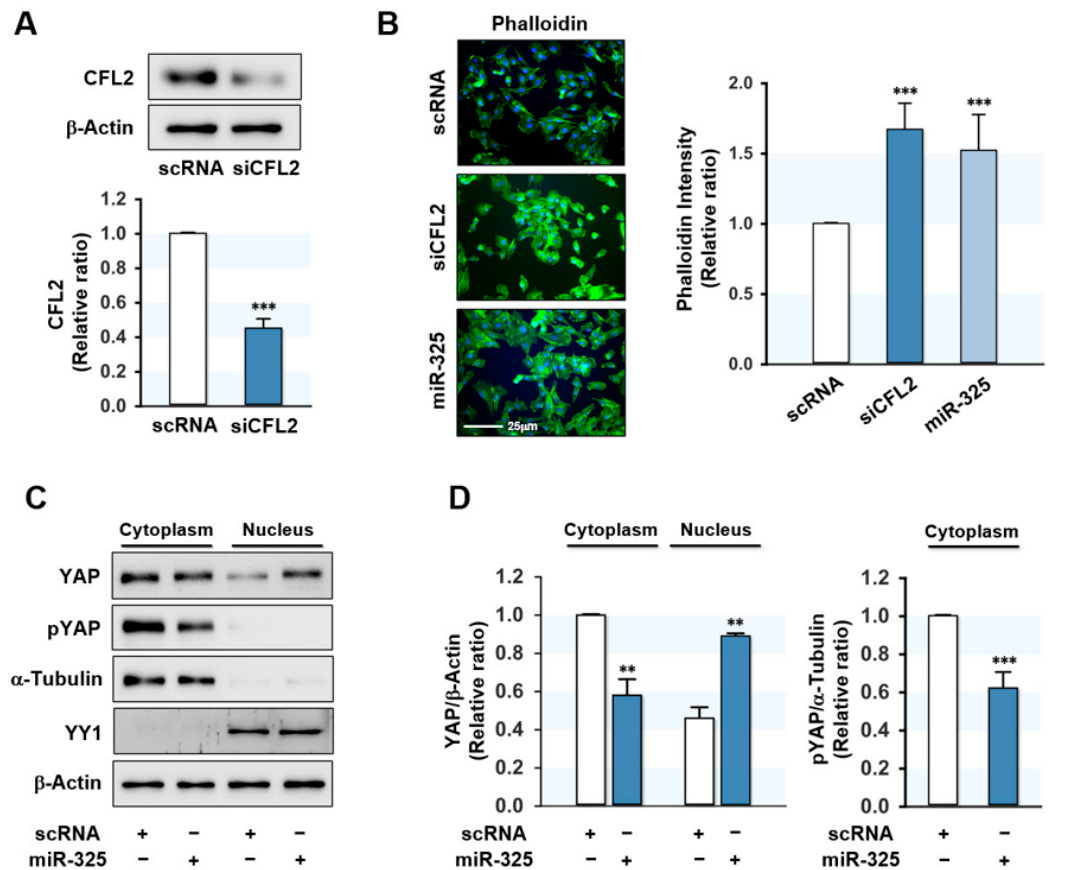
Figure 3. MiR-325-3p increased F-actin and nuclear YAP levels. ( A ) C2C12 myoblasts were transfected with 200 nM of scRNA or CFL2 siRNA (siCFL2), and CFL2 protein expression was determined 24 h after transfection by immunoblotting. Intensities were normalized versus β -actin. ( B ) Representative images of FITC-phalloidin (green) and Hoechst 33342 (blue) staining after 24 h of transfection. Scale bar: 25 μ m. Phalloidin intensities were analyzed by ImageJ software. ( C , D ) YAP and phosphorylated YAP (pYAP) protein expressions in the nuclear and cytoplasmic fractions were determined by immunoblotting after 24 h of transfection with scRNA or miR-325-3p mimic into C2C12 myoblasts. The quality of subcellular fractionation was confirmed using cytoplasmic ( α -Tubulin) or nuclear (YY1) markers. Immunoblot results are shown as relative ratios versus scRNA control. All results are presented as the means ± SEMs ( n > 3), and levels of significance are presented as **, p < 0.01; ***, p < 0.001 vs. scRNA controls.